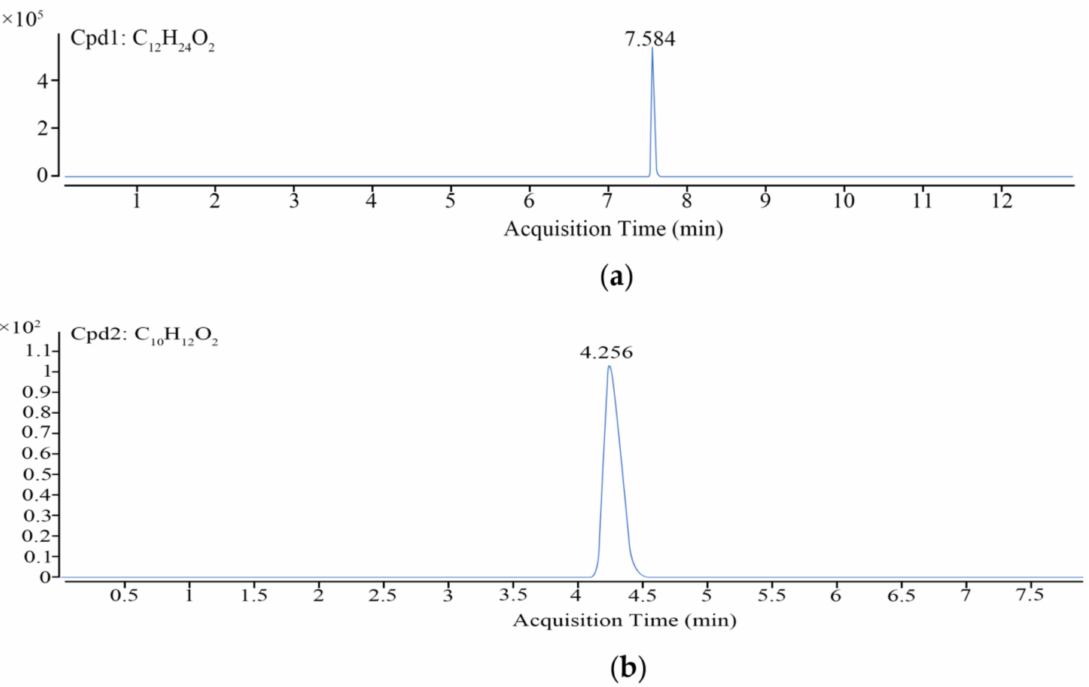
Figure 5. LC–MS analysis. ( a ) Quantitative ion chromatogram of lauric acid; ( b ) Quantitative ion chromatogram of